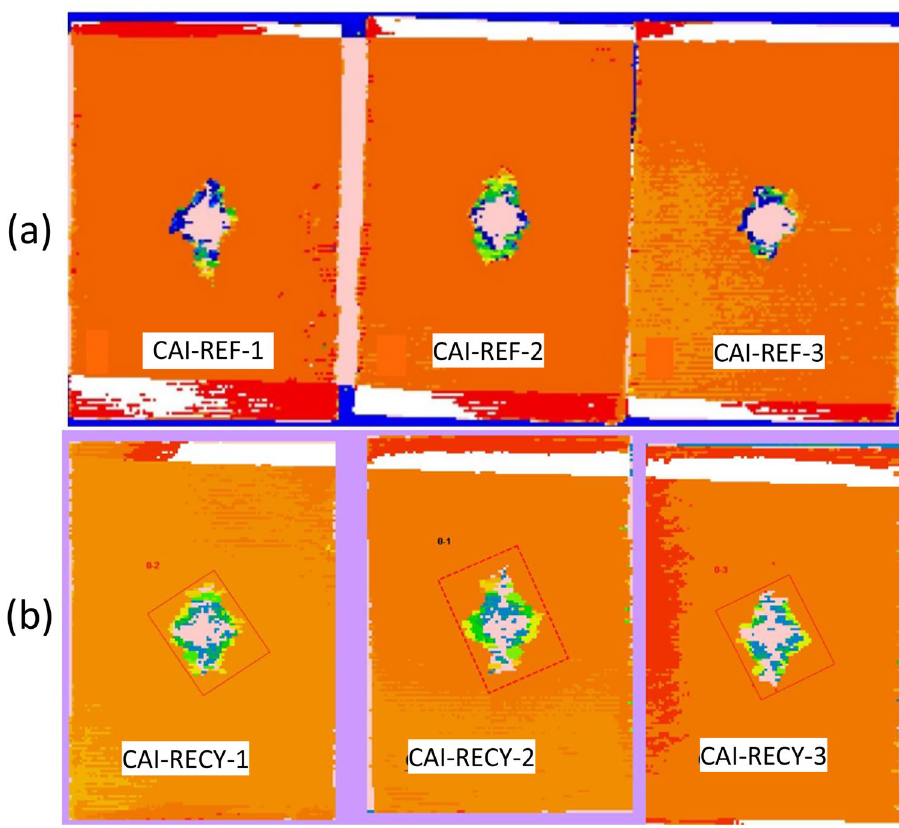
Figure 10. C-scan images of composites impacted at 24 J: ( a ) virgin and ( b ) recycled.